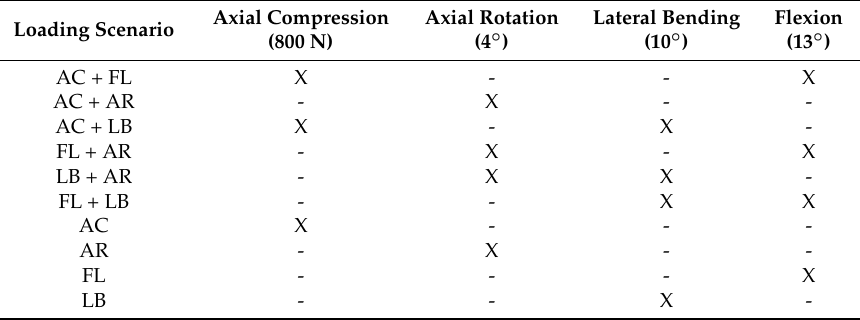
Table 3. Simple loading scenarios investigated in the numerical simulations.